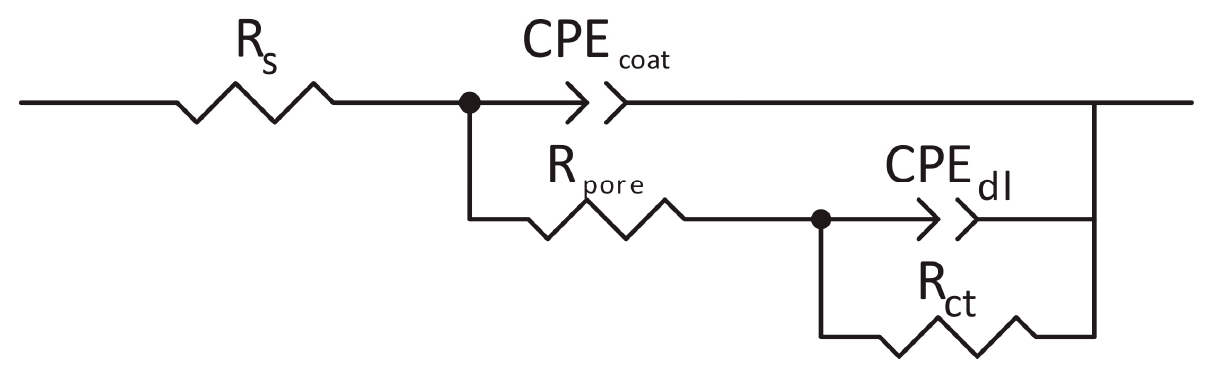
Figure 6. The equivalent circuit used to fit the experimental EIS data. Figure 7. The equivalent circuit used to fit the experimental EIS